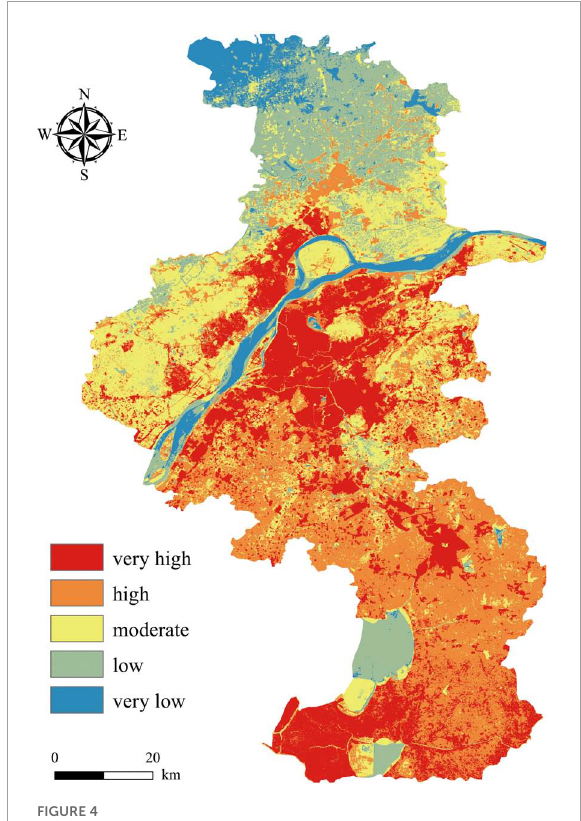
FIGURE4 The results of the flood vulnerability assessment.